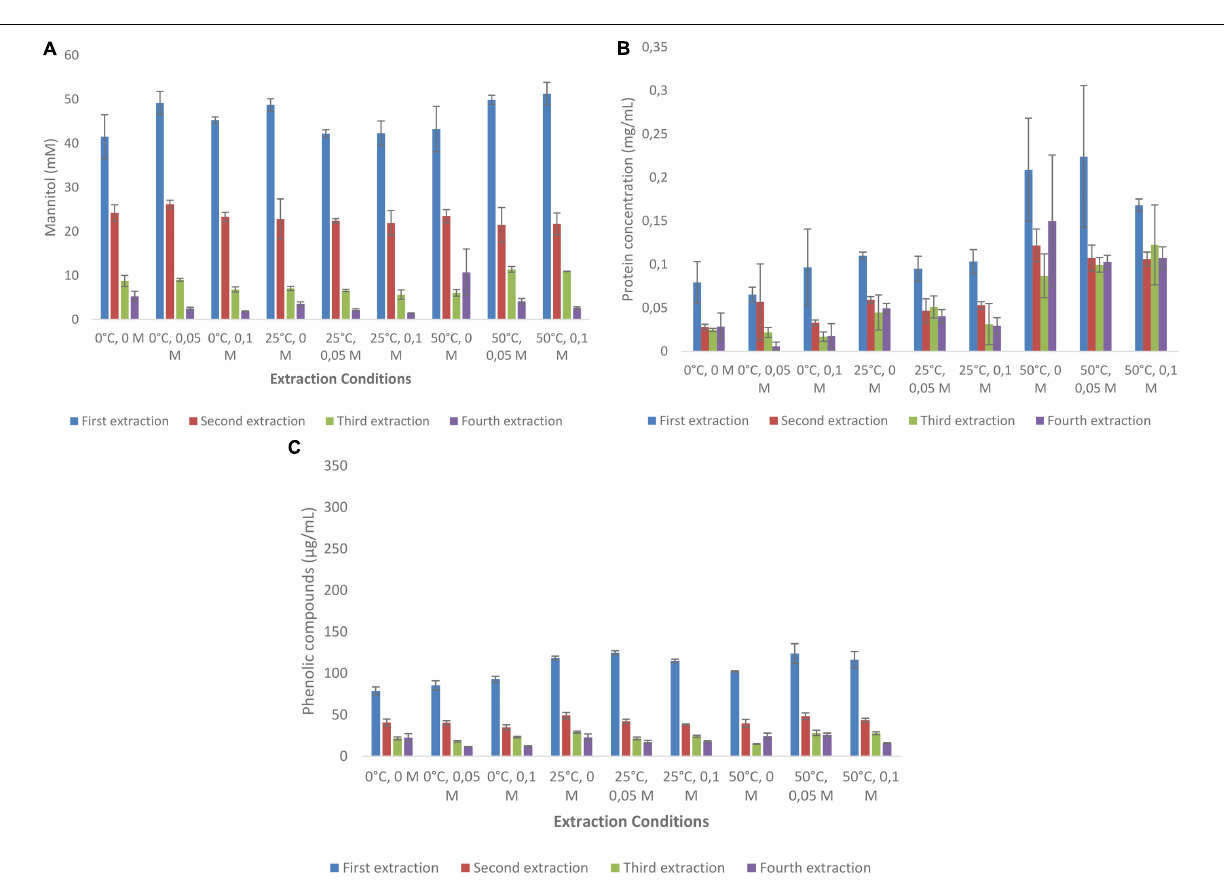
concentrations (0.21–0.22 mg/mL). Much lower